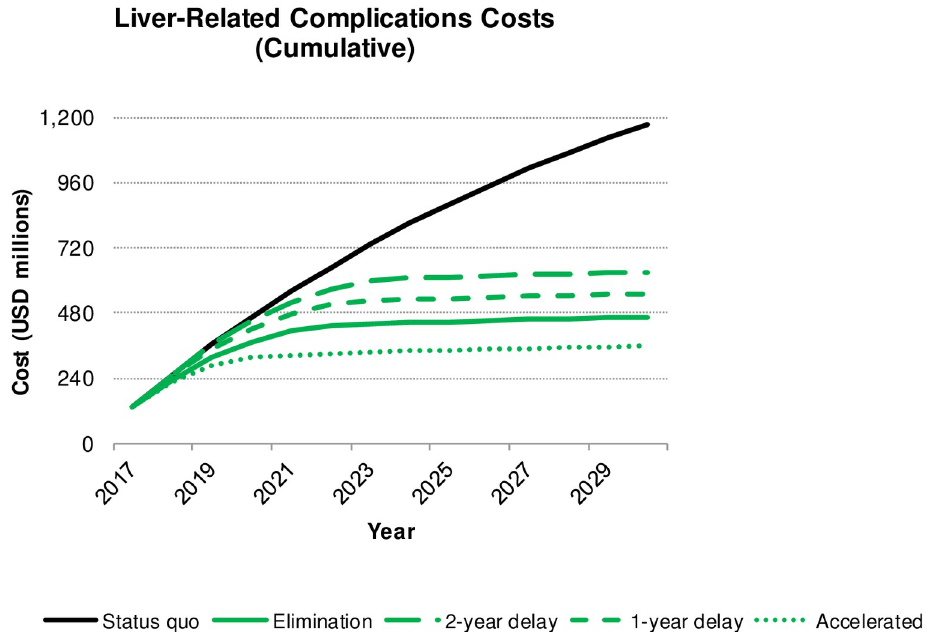
Fig 3. Change in cumulative cost of HCV liver-related complications, by scenario, 2017–2030.